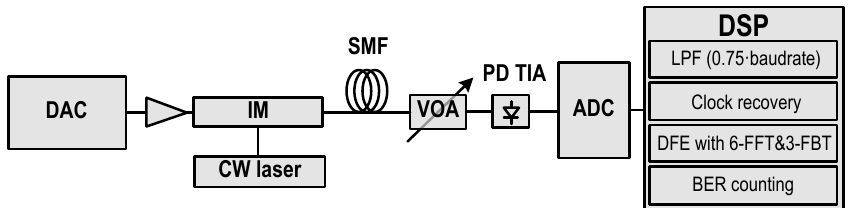
Figure 5. Simulation setup. DAC: digital to analog converter, CW laser: continuous-wave laser, IM: intensity modulator, SMF: single-mode fiber, VOA: variable optical attenuator, PD-TIA: photodetector with a transimpedance amplifier, ADC: analog to digital converter, DSP: digital signal processing, LPF: low-pass filter, DFE: decision feedback equalizer, FFT: feed-forward taps, FBT: feedback taps, BER: bit error rate. Table 1. Simulation setup parameters.